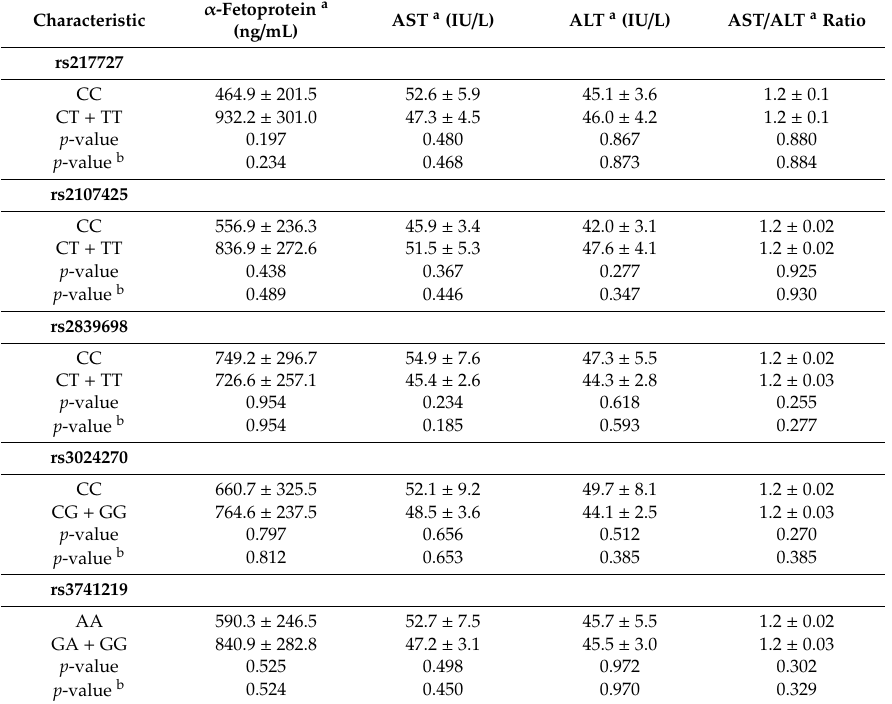
Table 4. Association between H19 genotypic frequencies and the HCC laboratory